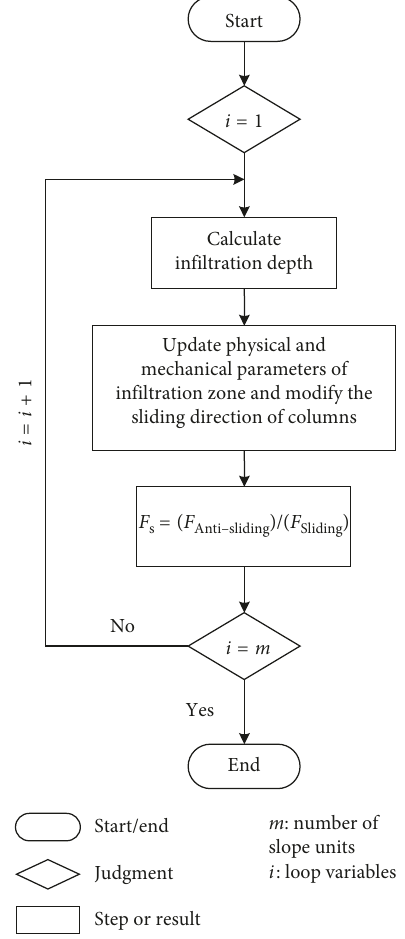
Figure 8: Flowchart of regional planar sliding of slope based on